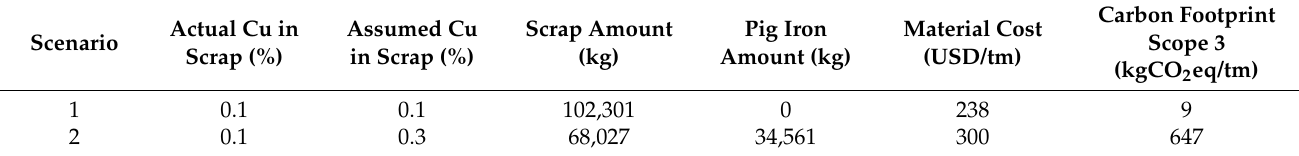
Table 1. Cost and scope 3 carbon footprint results for two scenarios of copper content assumptions in a scrap